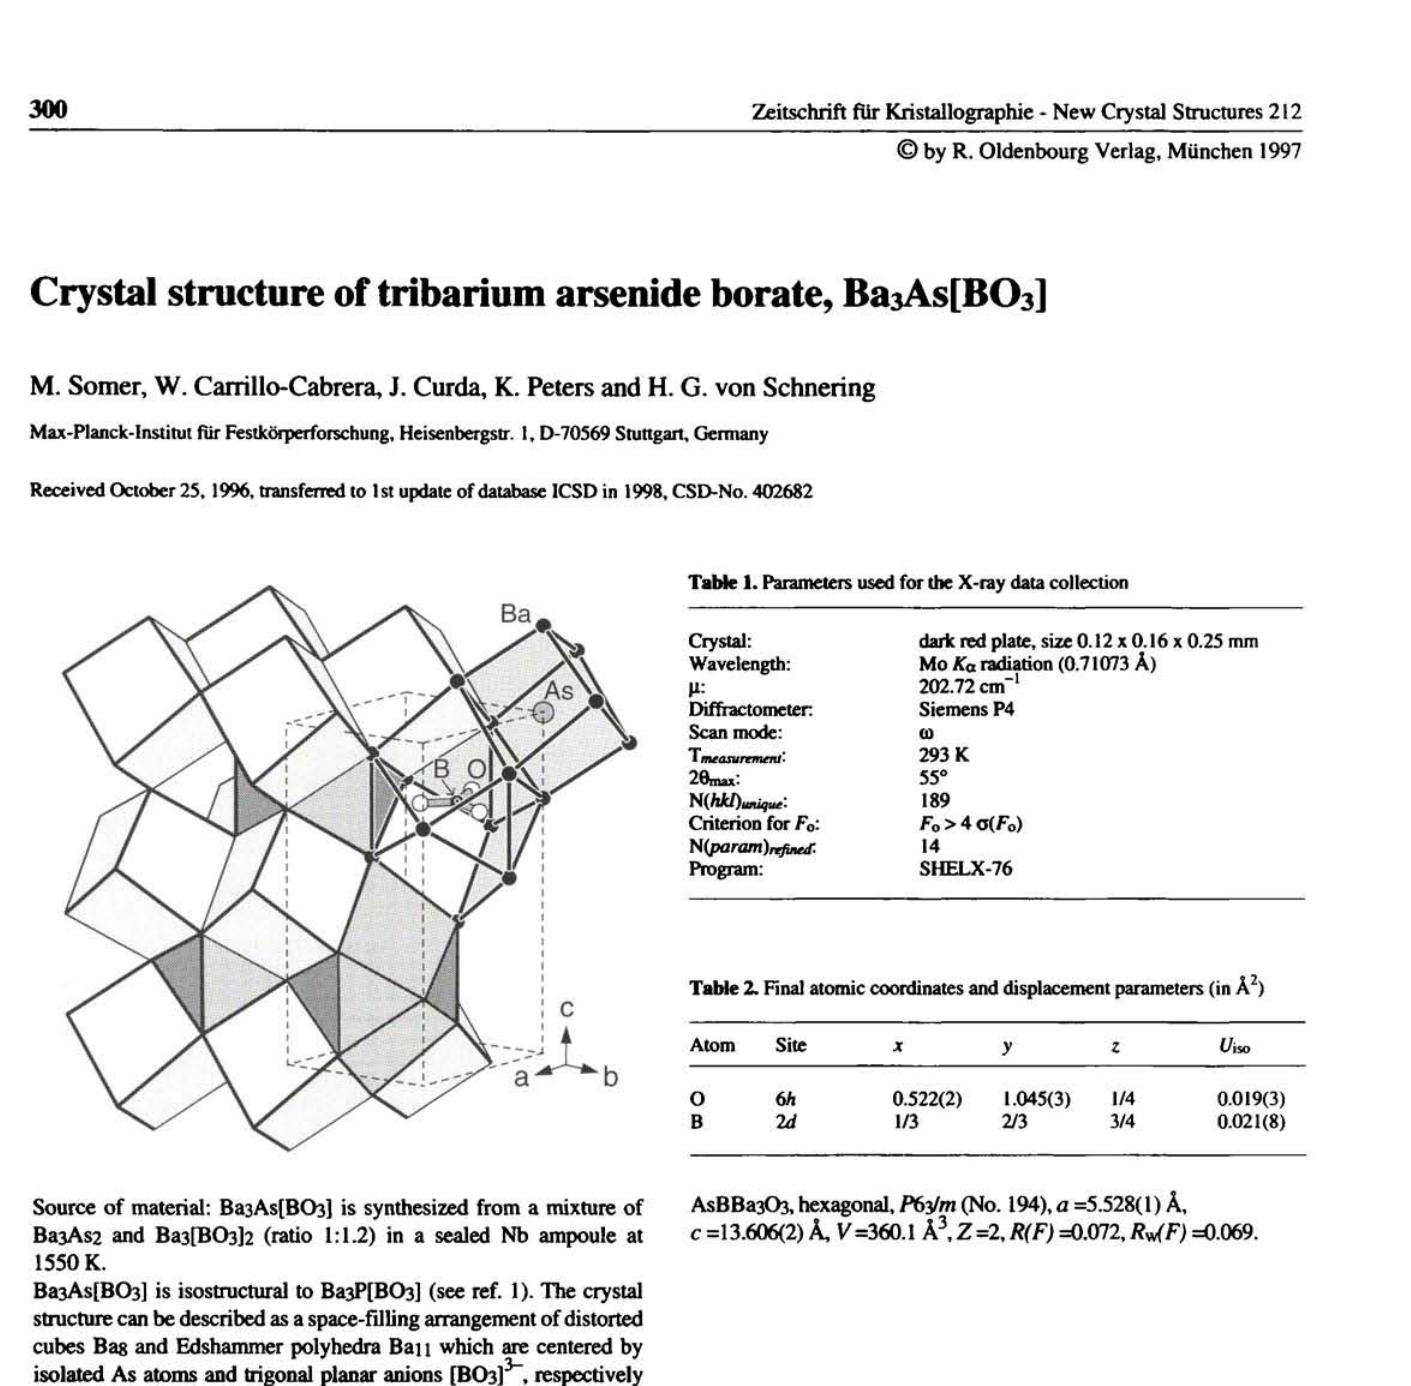
Table 3. Final atomic coordinates and displacement parameters (in Â 2 )